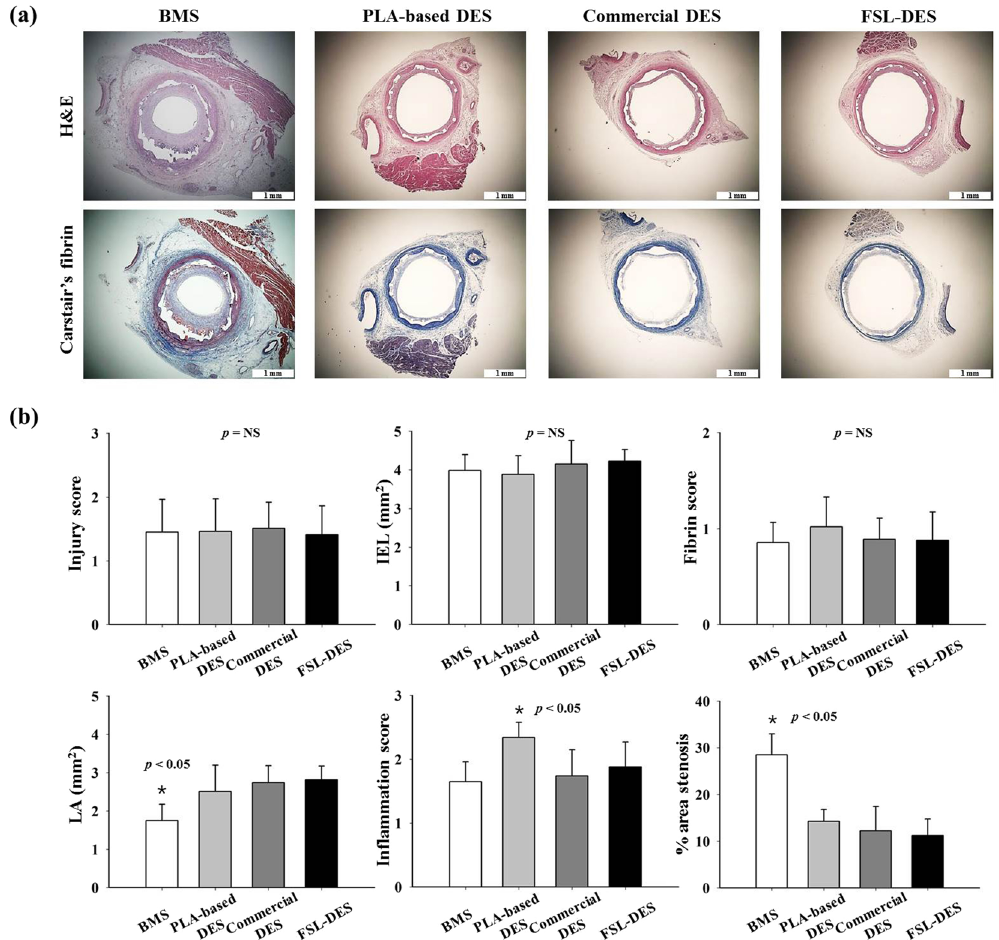
Figure 7. Histological analysis of the porcine coronary restenosis model. After 4 weeks of implantation, the vessels surrounding stents were isolated and subjected to H&E and Carstair’s fibrin staining. Representative images of sections ( a ) and histomorphometric analyses ( b ) are shown. Magnifications of the cross-sectional slices were 25 × . (n = 10), NS, not statistically